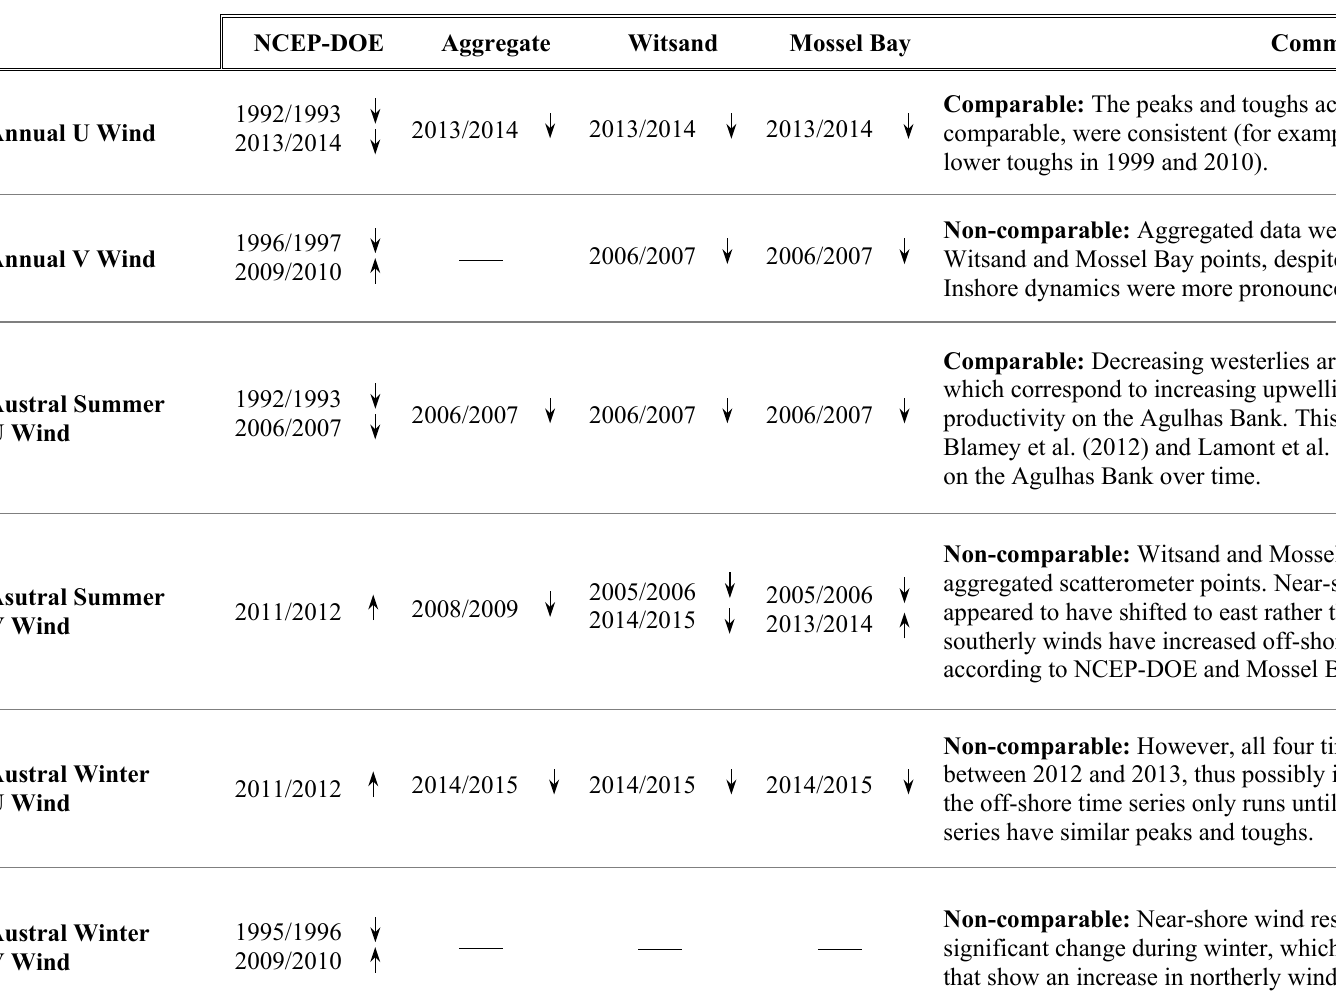
Table A 5 .1: Wind regime patterns for annual and austral seasons between near- and off-shore time series analysing the